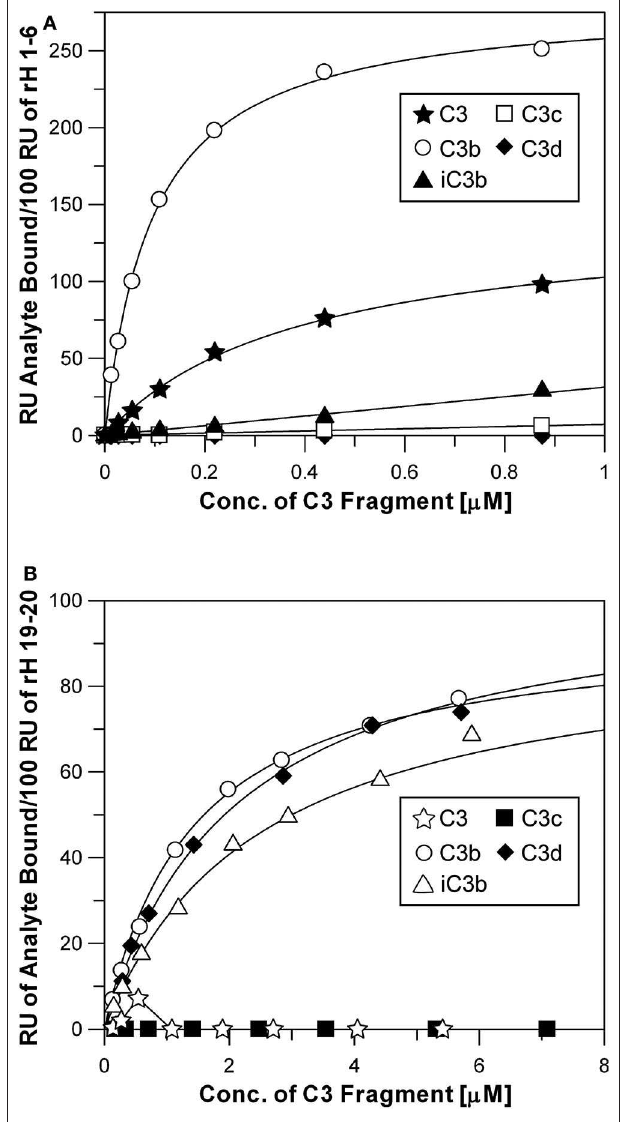
FIGURE 6 | Specificity of rH 1-6 and rH 19-20 for C3 and degradation products of C3. (A) Binding curves of rH 1-6 with different C3 fragments. The assays were performed in the same way as described in Figures 2 , 3 . Each data point was generated from at least three separate binding assays. Different concentrations (0.01–0.88 µ M) of native C3, C3b, iC3b, C3c, and C3d in HBS-P were injected over the chips as described in Figure 3 . The K d was determined by fitting the data by non-linear regression using the GraFit 5 program as described in Figure 4 . (B) Same as above, except that purified rH 19-20 was attached to the NTA-Ni surface and higher concentrations (0.1–7.1 µ M) of the C3 fragments were used in order to approach saturation with this lower affinity